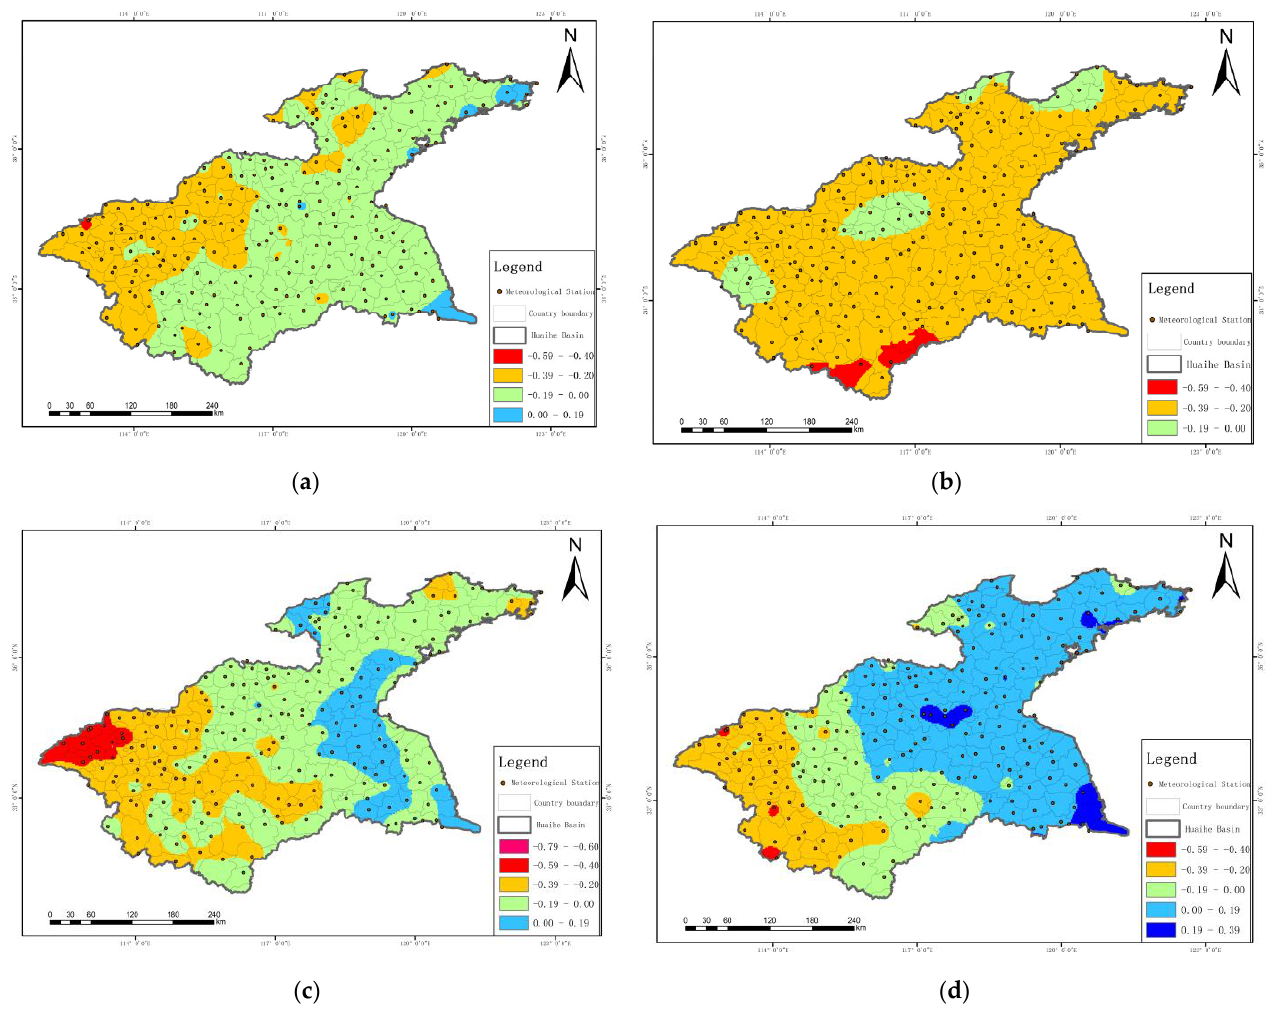
Figure 8. Spatial distribution of Pearson correlation coefficients in different seasons. ( a ) Spring, ( b ) Summer, ( c ) Autumn and ( d ) Winter.